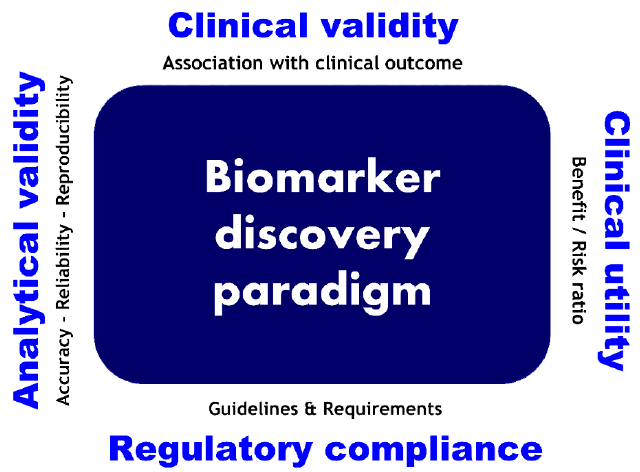
Figure 3. Biomarker development pipeline milestones.